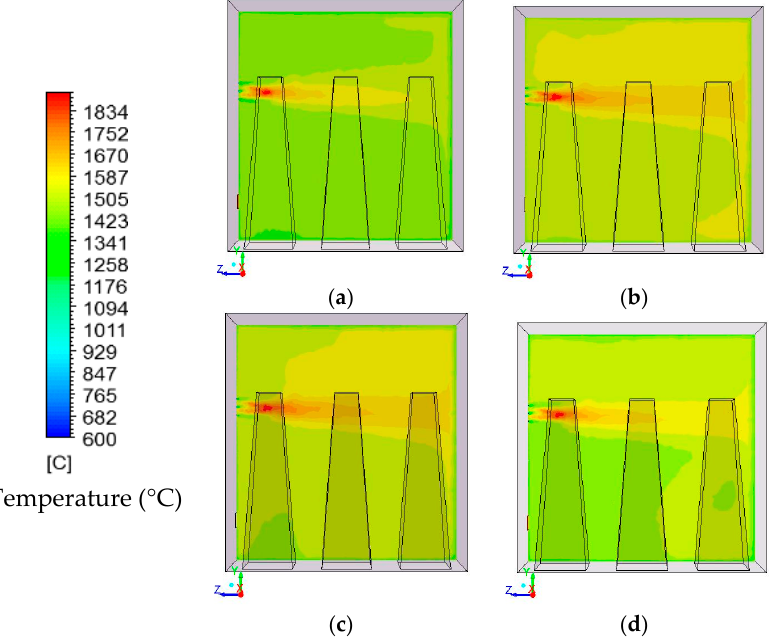
Figure 7. Predicted temperature (°C) profiles on a z - y surface in the middle of the furnace for